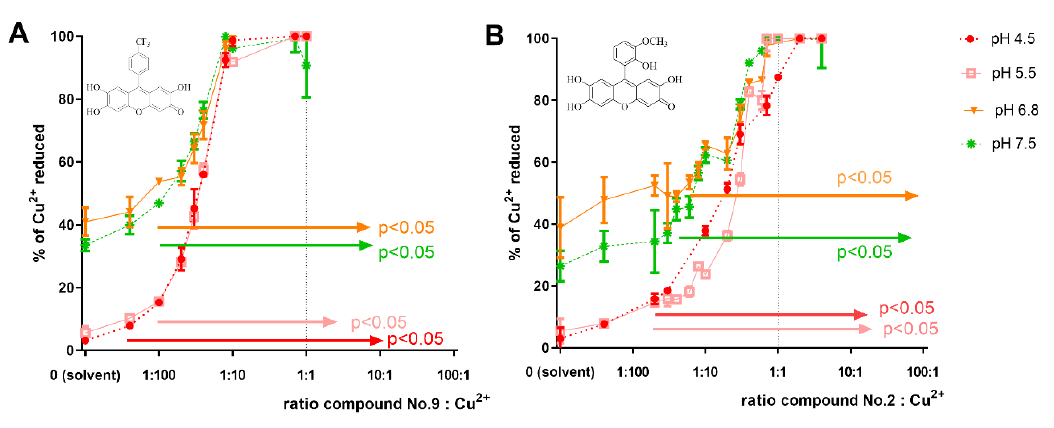
Figure 5. Copper reduction—examples. A : 4′-trifluoromethyl ( 9 ) and B : 2′-hydroxy-3′-methoxy ( 2 ) derivative. The arrows show significance vs. the solvent at corresponding pH. The final concentration of cupric ions was 50 µM in all cases.